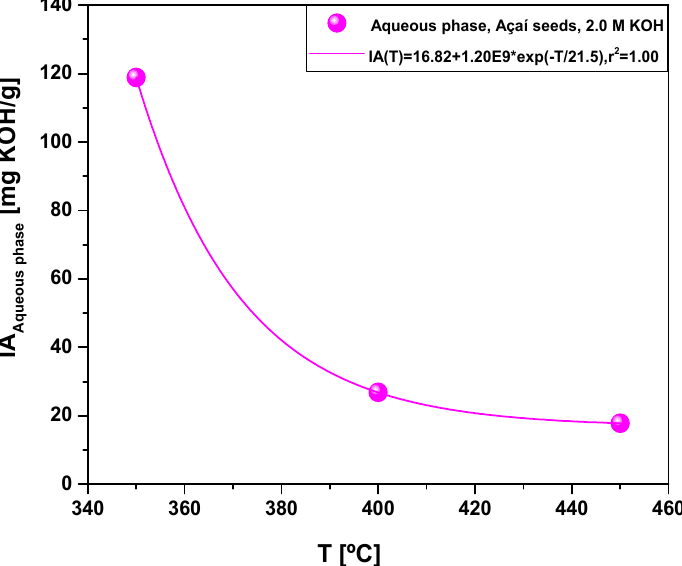
Figure 8. Acidity of aqueous phase obtained by pyrolysis of Açaí seeds, activated with 2.0 M KOH solution, at 350, 400, and 450 °C, 1.0 atmosphere, in laboratory scale.